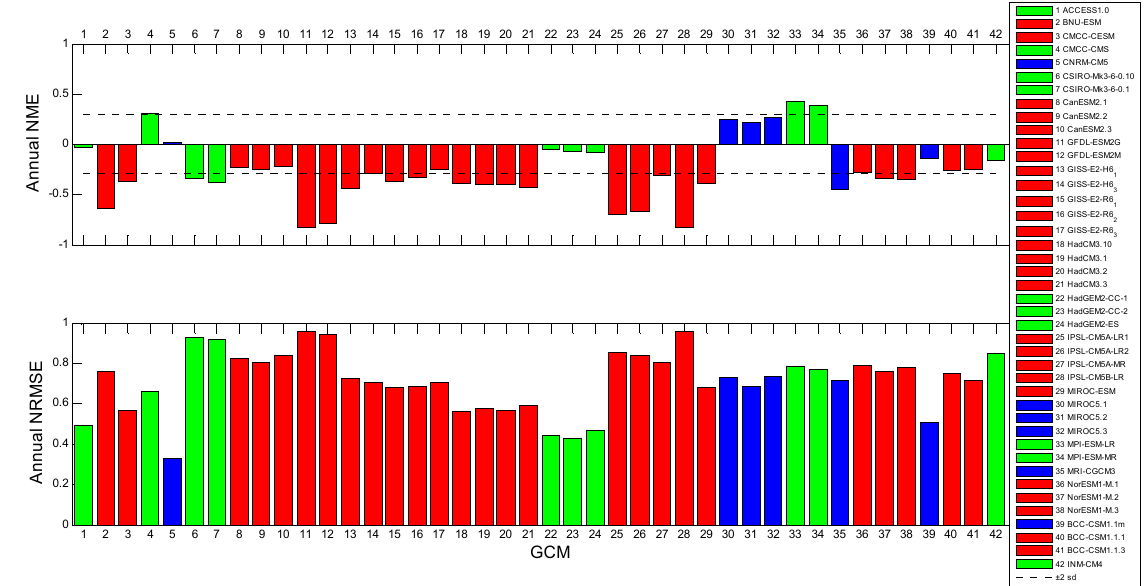
Figure 6. NME and coefficient of variation of the root mean square error (CV(RMSE)) of average annual precipitation for the GCM simulations compared to the observed series, red: LR GCMs; blue: HR GCMs; green: MR